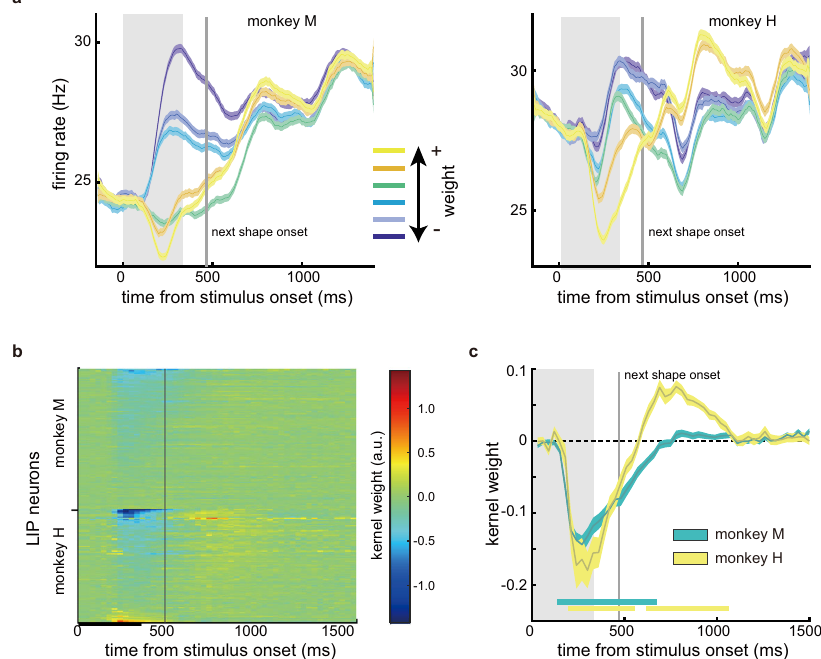
Fig. 3 | LIP neurons encoded shape weights. a The PSTH (left: monkey M, right: monkey H)aligned to the onset ofthe shapes, averagedacross the epochs and the trials. The traces are sorted by shape weight. b Response kernels for shape weight based on the Poisson GLM. Each row is a neuron, and the colors denote the gain. Red and blue indicate positive and negative kernel weights, respectively. Most neuronsshownegativekernelweights(blue,monkeyM:76outof115,monkeyH:53 outof92),indicatingthattheshapeswithapositiveweightsuppressLIPresponses.